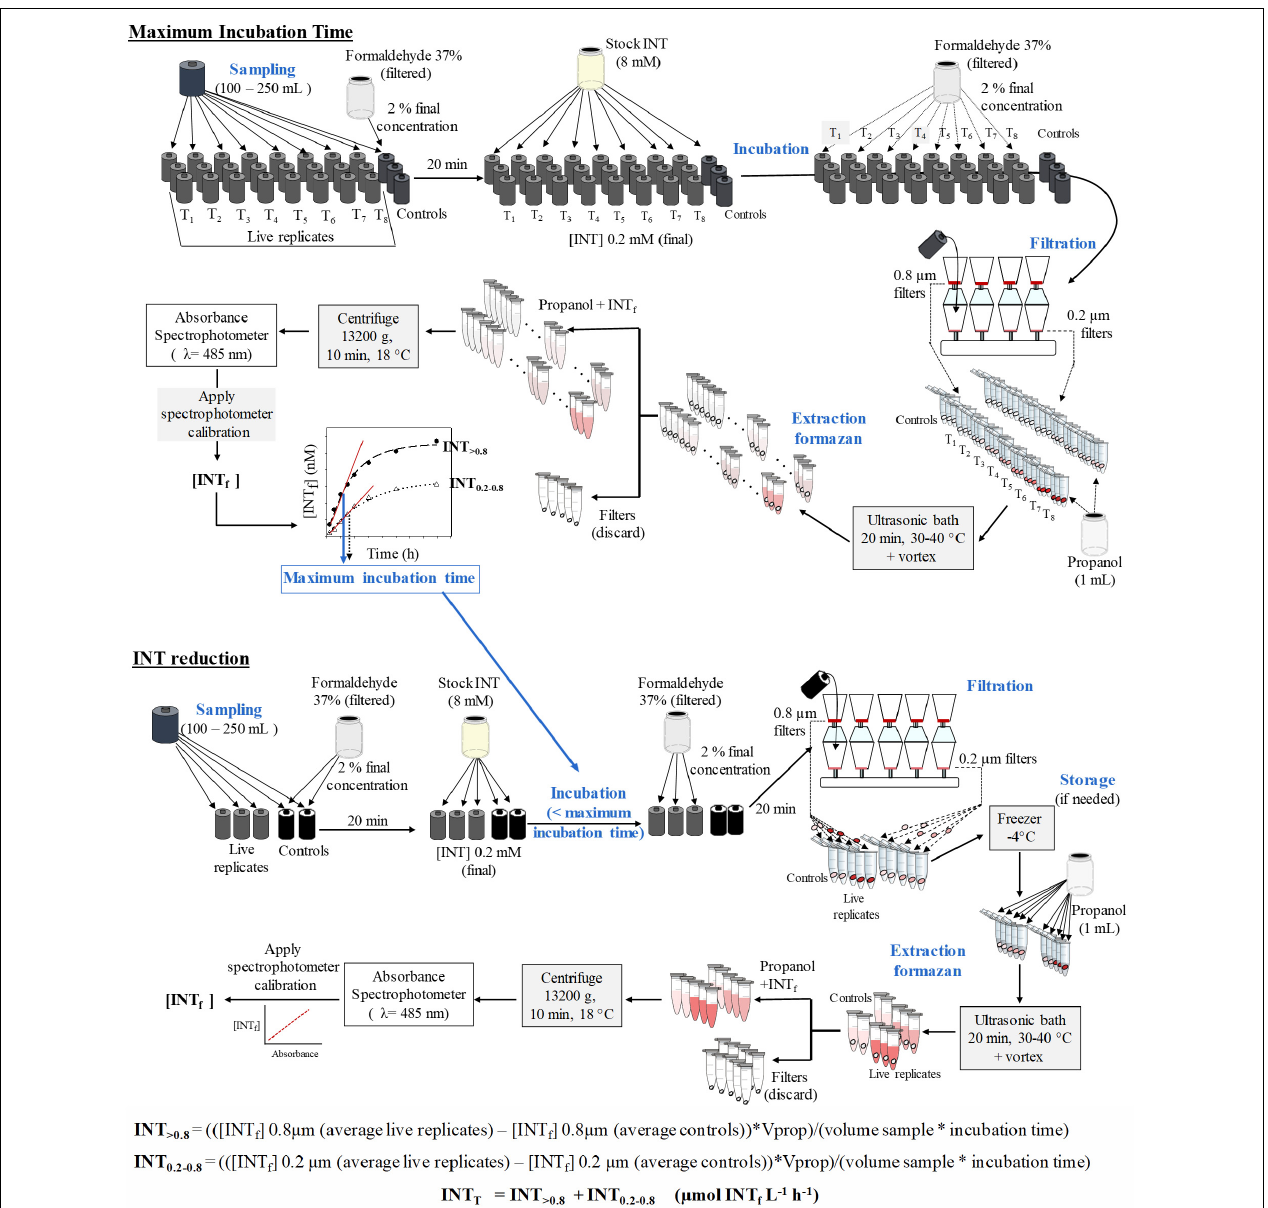
FIGURE 1 | Schematic diagram for the INT reduction method. Upper panel: scheme for the calculation of maximum incubation time. Lower panel: scheme for the sampling, extraction and analysis of the reduction of INT. INT f , INT formazan; Vprop, volume of propanol.